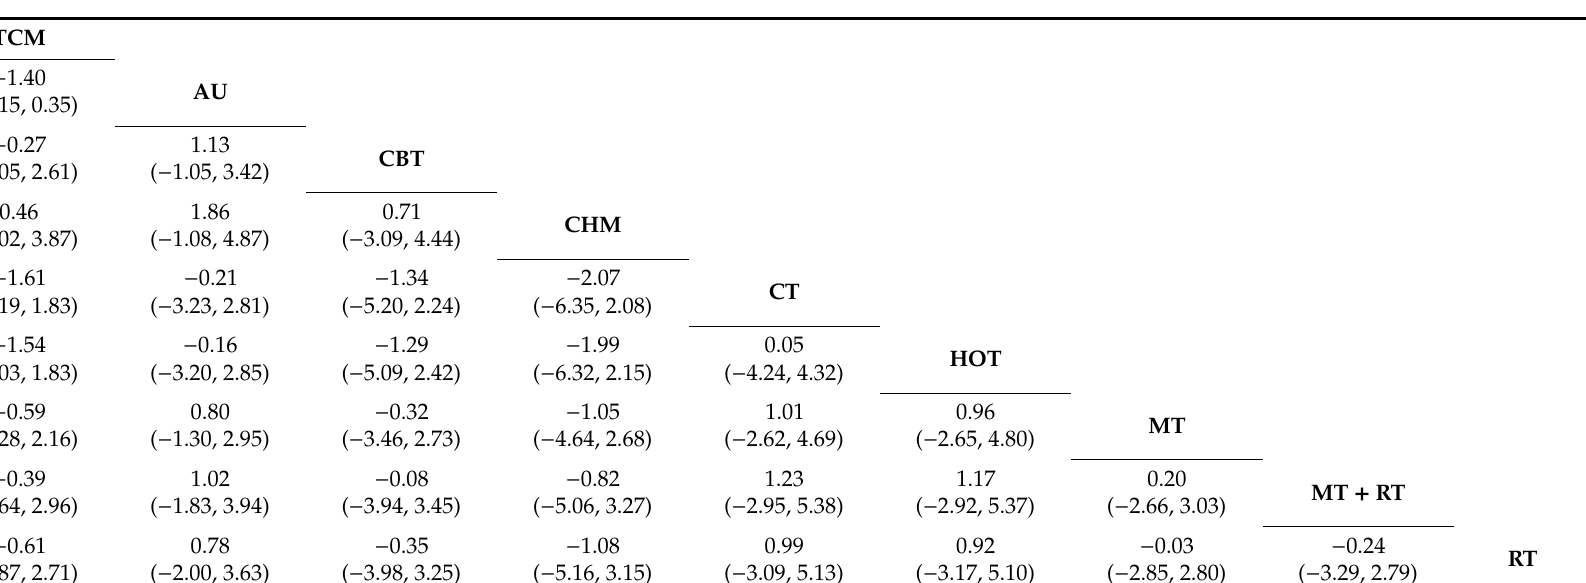
Table 2. Network meta-analysis for